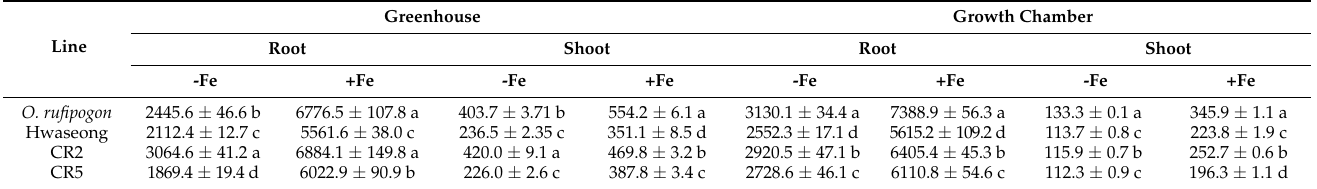
Means in each column with different letters are significantly different from each other at p = 0.05 based on Tukey’s test. Error bars represent the ± standard deviation of the mean. All values repre- sent the mean of three replicates.